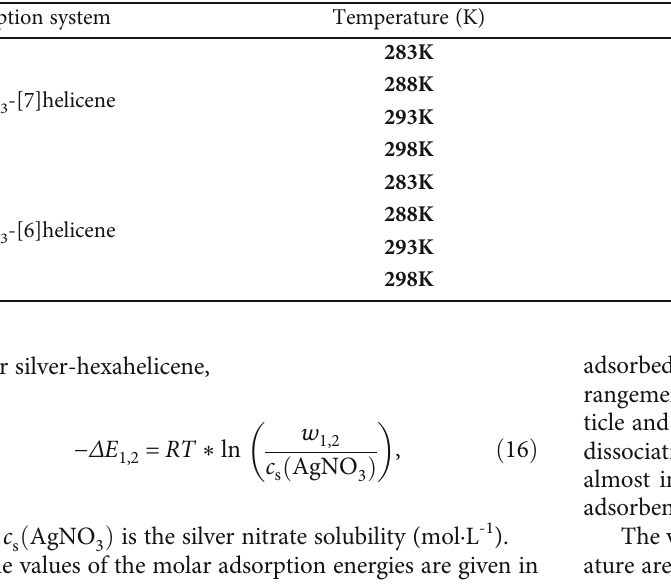
| (kJ/mol) and|- Δ E | (kJ/mol) describing the complexation of the two 1 2